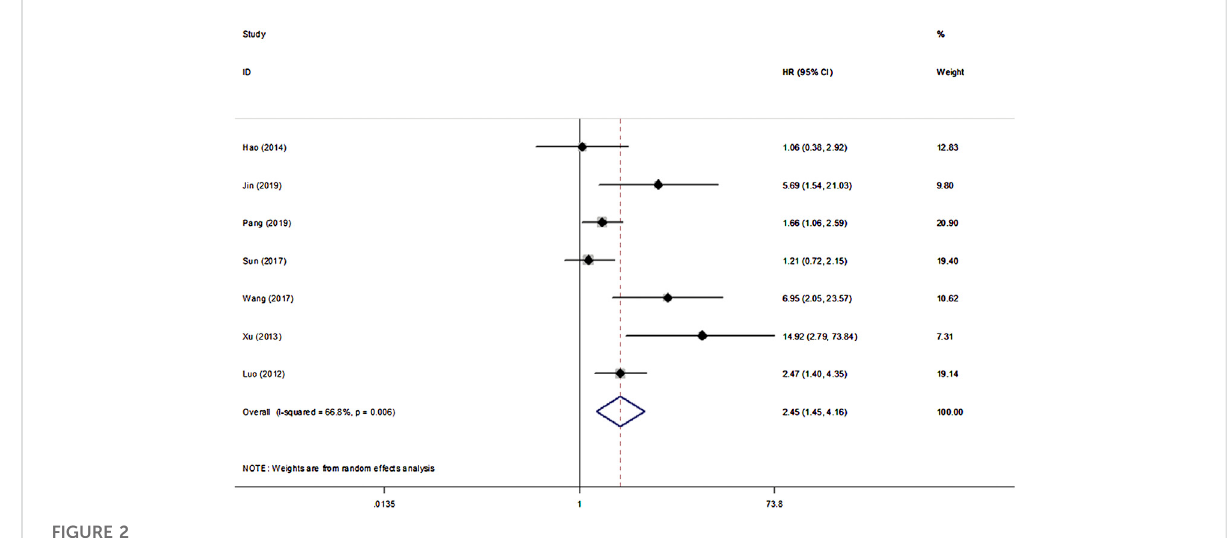
FIGURE 2 Forest plot indicating the association between β -Catenin expression and OS in NPC.